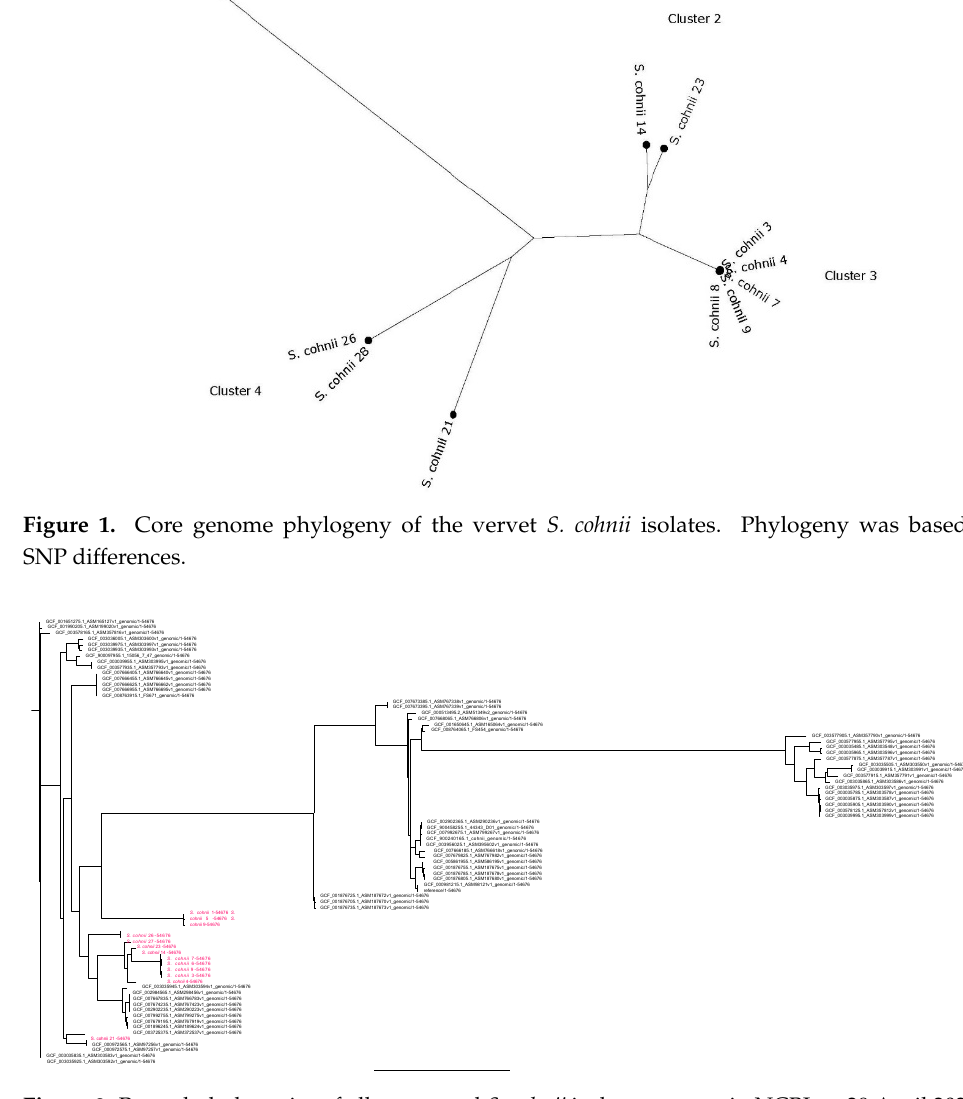
Figure 2. Rooted phylogenies of all sequenced S. cohnii isolates present in NCBI on April 29. 2020.